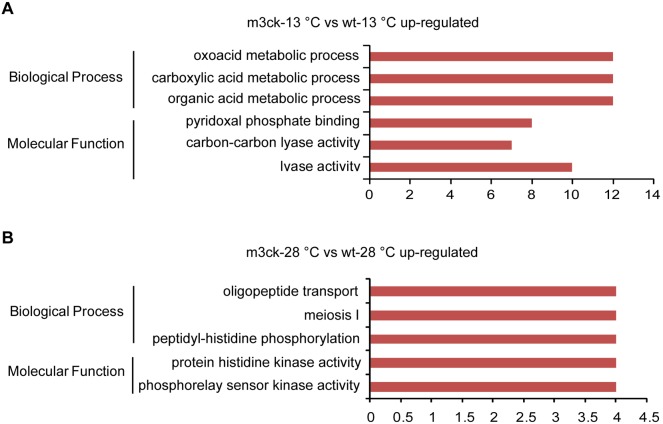
GO enrichment analysis of up-regulated transcripts between transgenic fish and wild-type fish under cold stress or normal temperature.A. m3ck-28°C vs. wt-28°C up-regulated transcripts. B. m3ck-13°C vs. wt-13°C up-regulated transcripts. The horizontal axis represents transcript count in each GO term. Up-regulated transcripts were submitted for GO enrichment analysis using the SAS online analysis system.